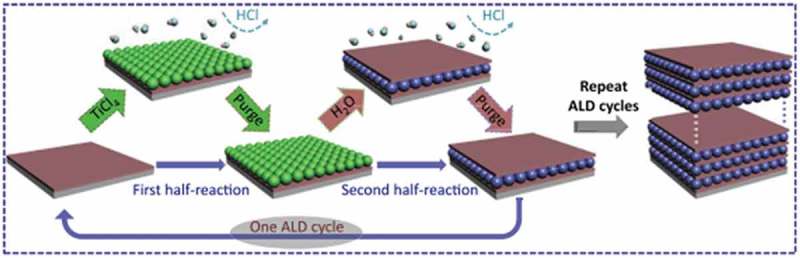
A model ALD process for depositing TiO2 on hydroxyl groups functionalized substrate using TiCl4 and H2O as precursors. Adapted with permission from [13], copyright Elsevier 2017.